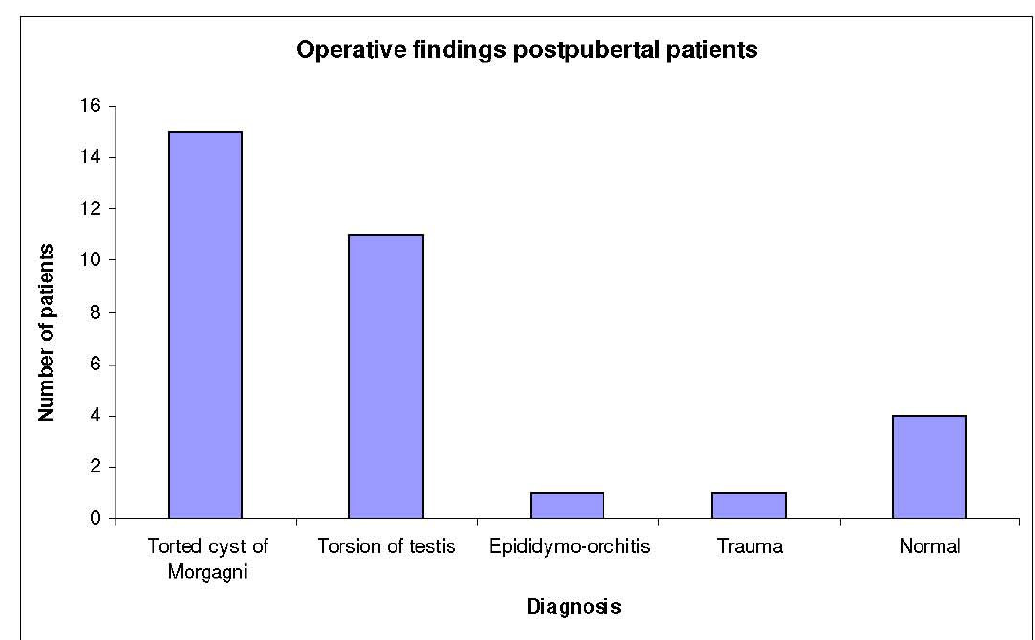
FIGURE 3. Operative findings in scrotal exploration in postpubertal patients (n =